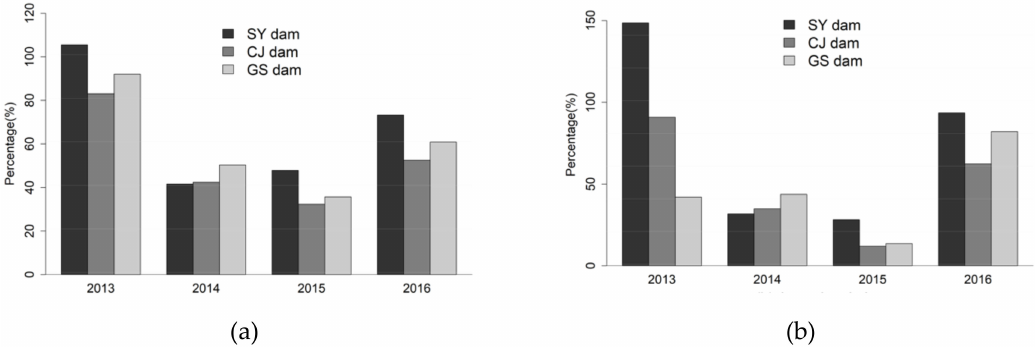
Figure 14. Percentages of ( a ) the inflow rate of the year compared to the mean annual inflow in the 2013 to 2016 years and ( b ) the variation rate of the year compared to the mean annual variation in the 2013 to 2016